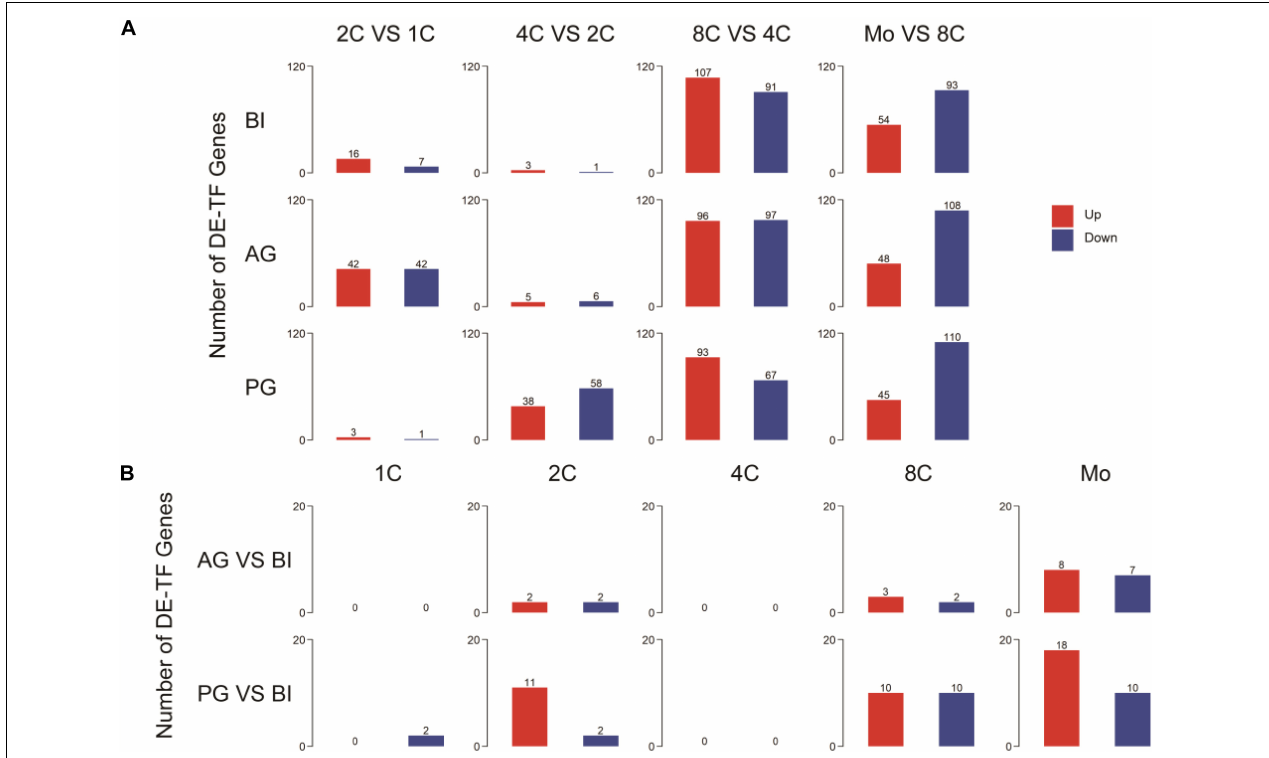
FIGURE 2 | Detection and annotation of DE-TFs between and within different embryos. (A) DE-TFs within different types of embryos. (B) DE-TFs between biparental and uniparental embryos.